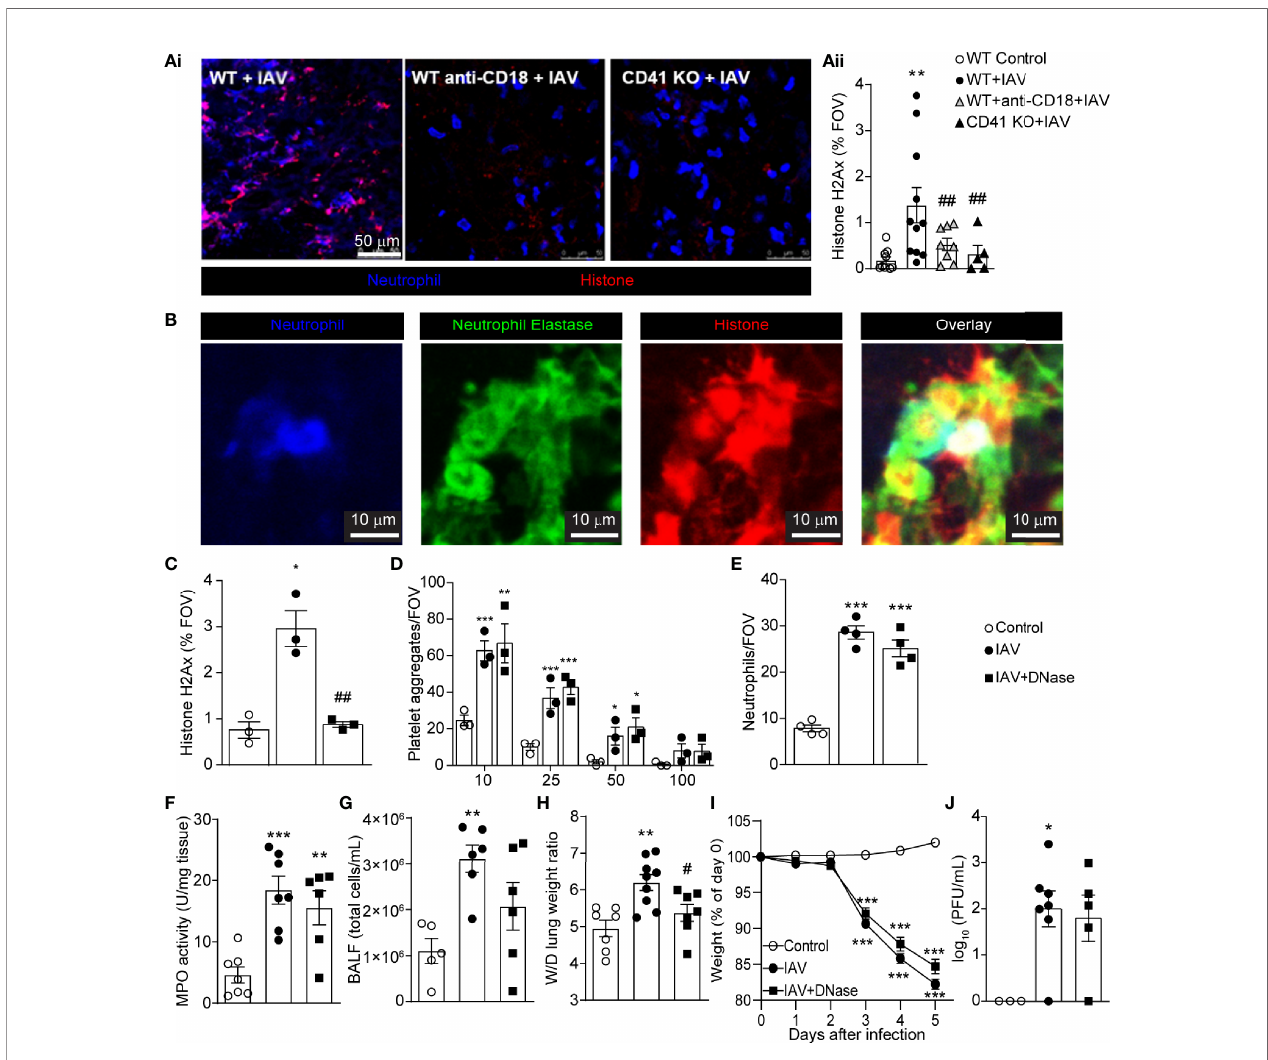
FIGURE 3 | IAV Infection Induces the Release of NETs within the Lung Vasculature. (Ai) IVM imaging of NETs in IAV-infected animals pretreated with anti-CD18 blocking antibody or animals de fi cient for CD41 (neutrophils, blue; extracellular histone, red). (Aii) Quanti fi cation of the area of staining of extracellular histone. Values represent staining area as a % of the FOV and are presented as the mean+/- SEM. n=5-9 per group (B) Representative IVM imaging of the lung vasculature 5d post-IAV infection (neutrophils, blue; neutrophil elastase, green; extracellular histone, red). Quanti fi cation of histone H2Ax (C), platelet aggregates of indicated sizes (D) and neutrophils (E) measured by IVM in mice treated with DNase. Quanti fi cation of lung MPO activity (F) , total BALF cellularity (G) , and lung wet-to-dry tissue weight ratios (H) following IAV infection of control and DNase-treated animals. Animal body mass (I) and lung viral loads (J) following IAV infection of control and DNase-treated animals. Values represent the mean +/- SEM. n = 5-9 per group. *p < 0.05, **p < 0.01, ***p < 0.001 compared to the control group. # p < 0.05, ## p < 0.01 compared to the IAV-infected